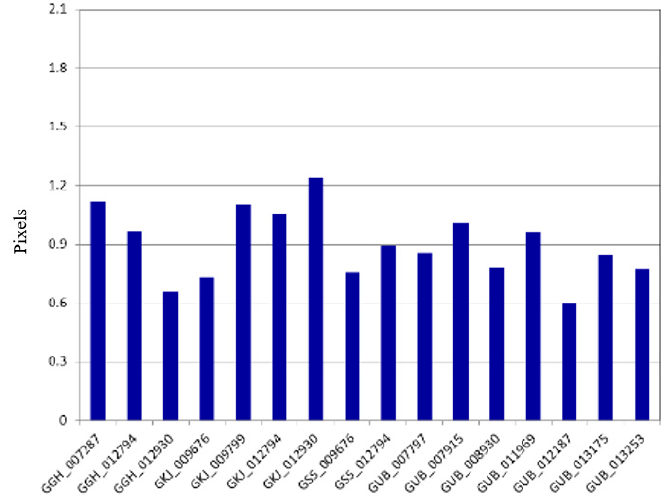
Figure 13. Mapping accuracy for 16 independent data.